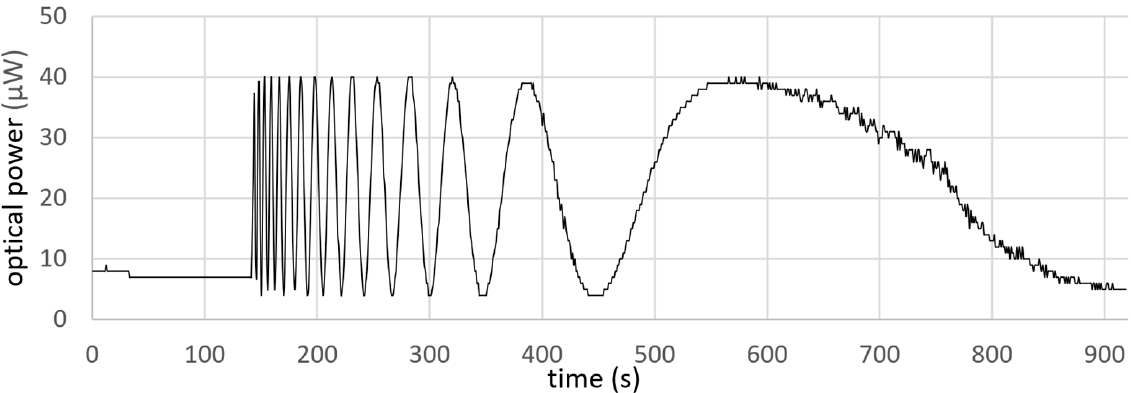
Figure 7. Changes in light power (µW) in time (s) as detected by the assembled sensor at 1550 nm, with measurements performed using a photodiode (DWDM (44 plus 5 km)) and an exposure temperature of 0 °C (a measurement of 355 s). Nearly identical results were achieved during the control measurements with the Fi- ber Bragg Gratings (FBGs). The PM sensors responded very well to rapid changes in the monitored physical quantity, e.g., the temperature. Slow changes, on the other hand,